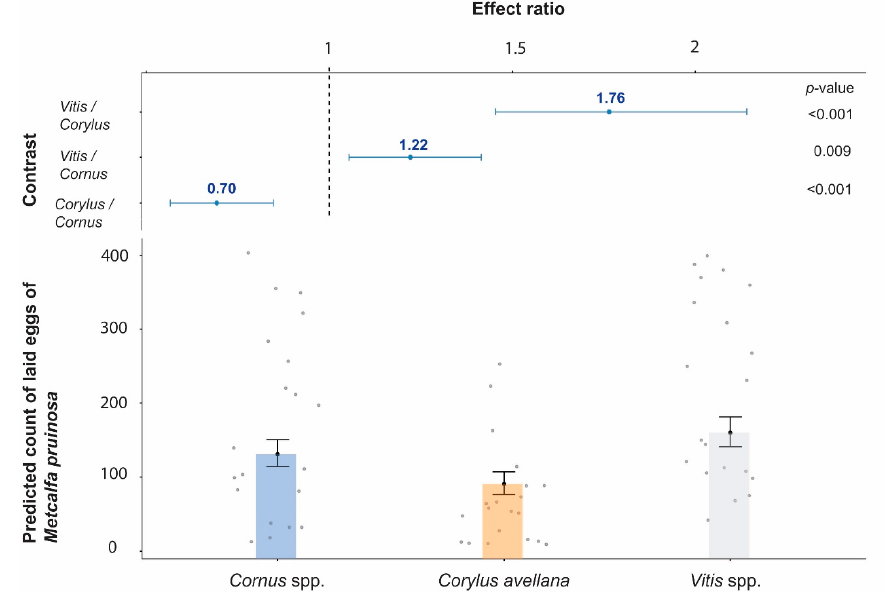
Figure 4. Top: the y-axis shows all pairwise comparisons among the three Plant Species levels, while the x-axis represents the response which is the ratio of the means of the two groups of Plant Species in the comparison ( p -values from the hypothesis tests are included on the right). Bottom: the estimated marginal means of Metcalfa pruinosa oviposition on the three Plant Species. Data are presented on the back-Poisson negative binomial scale with 95% confidence intervals (CI). Model coefficients are provided in the Supplementary Material.